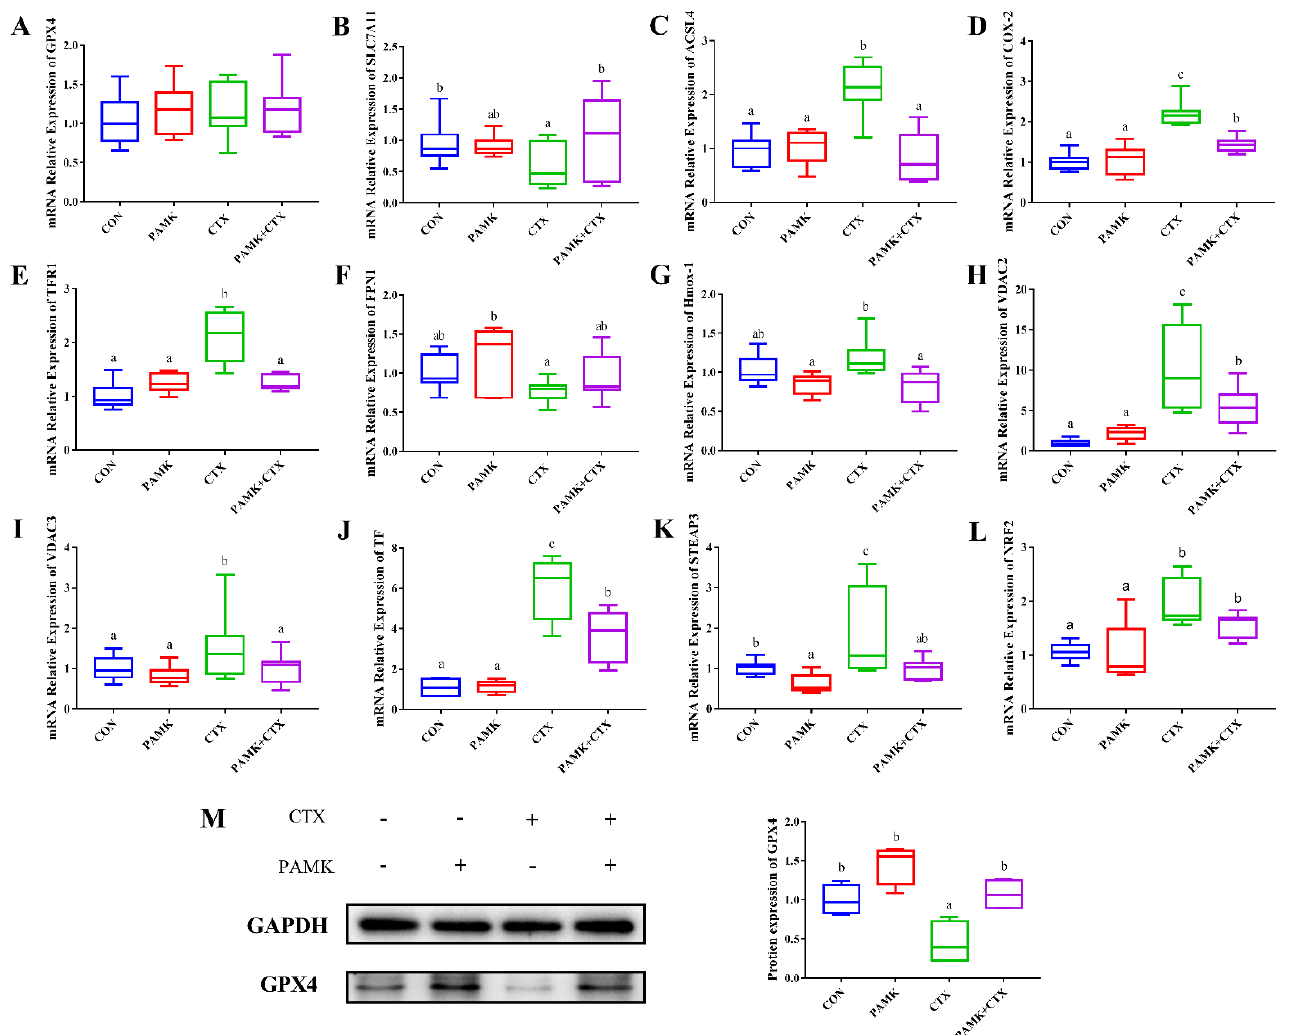
Figure 6. Effects of PAMK on the expression of thymus ferroptosis pathway gene treated with CTX. Relative mRNA expression of ( A ) GPX4; ( B ) SLC7A11; ( C ) ACSL4; ( D ) COX-2; ( E ) TFR1; ( F ) FPN1; ( G ) Hmox-1; ( H ) VDAC2; ( I ) VDAC3; ( J ) TF; ( K ) STEAP3;( L ) NRF2. Protein expression of ( M ) GPX4. Data are expressed as min to max, n = 10. Different letters indicate p < 0.05, significantly different.